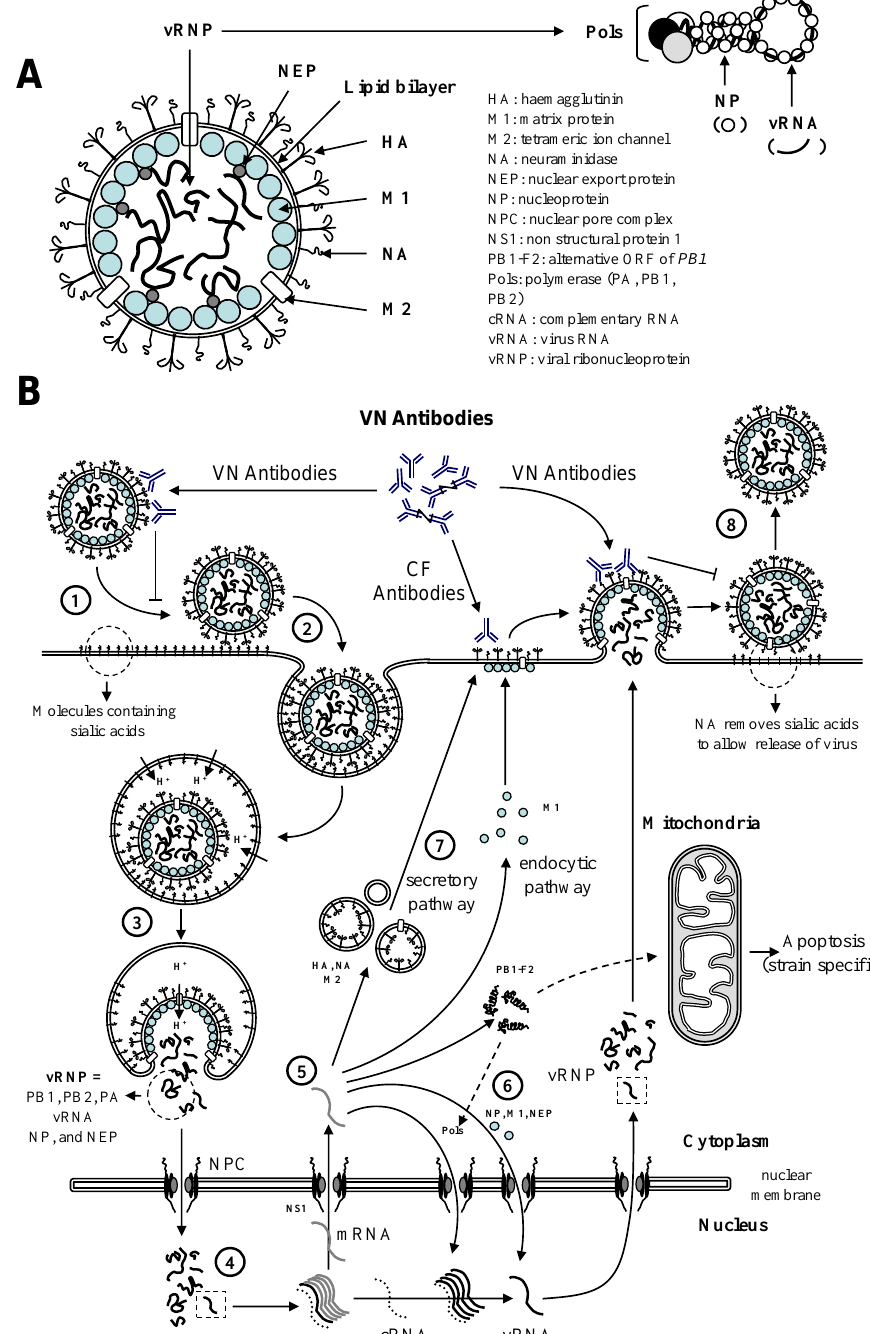
Figure 2. ( A ) EIV structure; ( B ) The reproductive cycle of influenza A virus. The virus binds to receptors on the surface of the cells (1) and is internalized into endosomes (2). Modification of pH in both the endosome and the virus induces fusion and uncoating of the virus (3). vRNP are released into the cytoplasm and imported into the nucleus where their replication takes place (4). mRNA are produced and exported into the cytoplasm for protein synthesis (5). This is controlled by NS1. These viral proteins will either assist replication of the virus and formation of vRNP into the nucleus (6), or form new viruses at the cell surface (7). Progeny viruses are assembled and bud from the cell membrane (8). CF = complement fixing; VN = virus